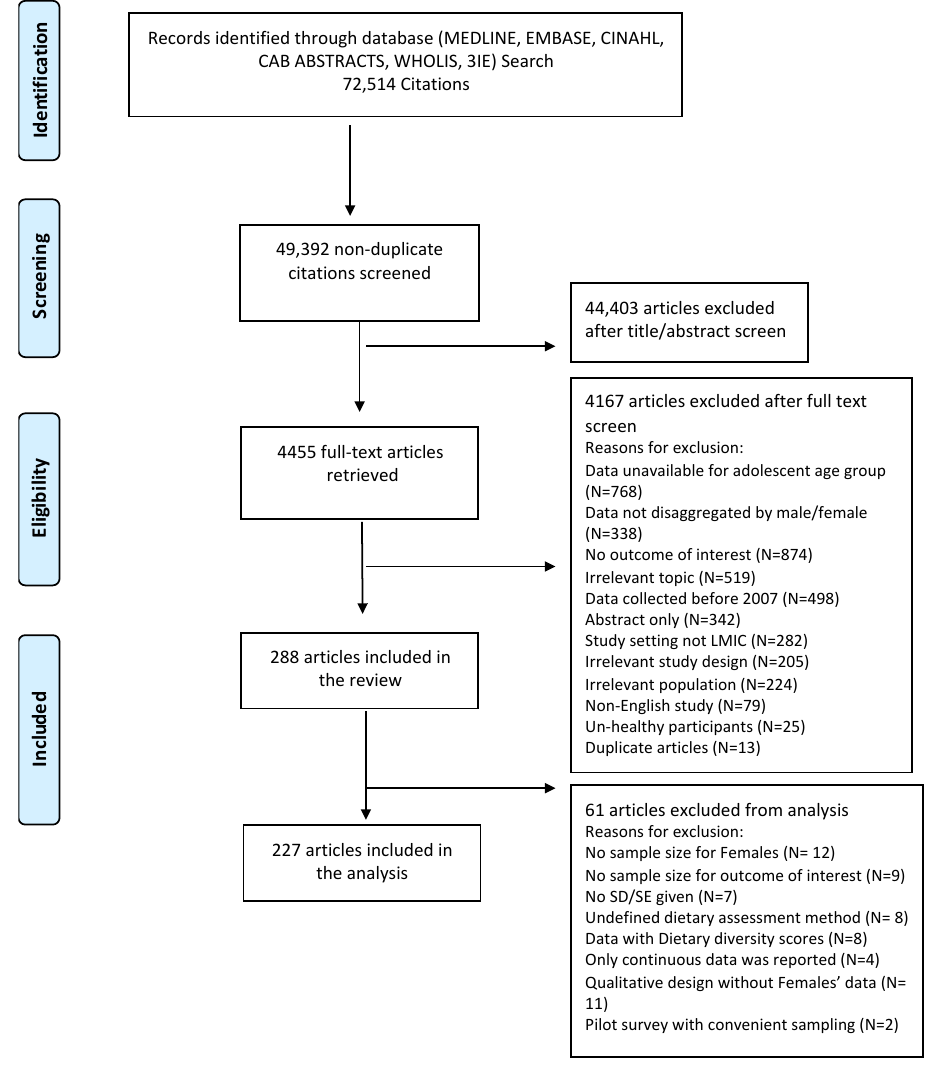
Figure 1. Flow diagram for study retrieval and selection. Table 1. Summarized study